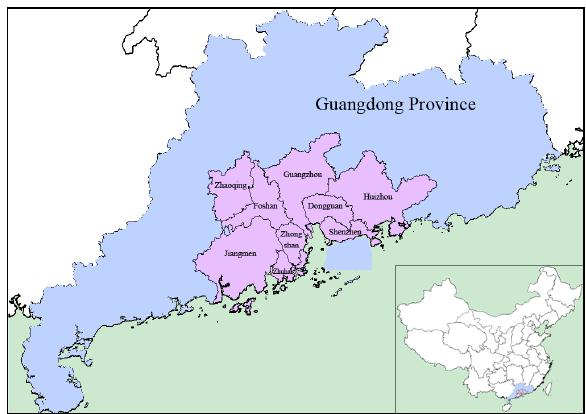
Fig. 1. The PRD region and its location.